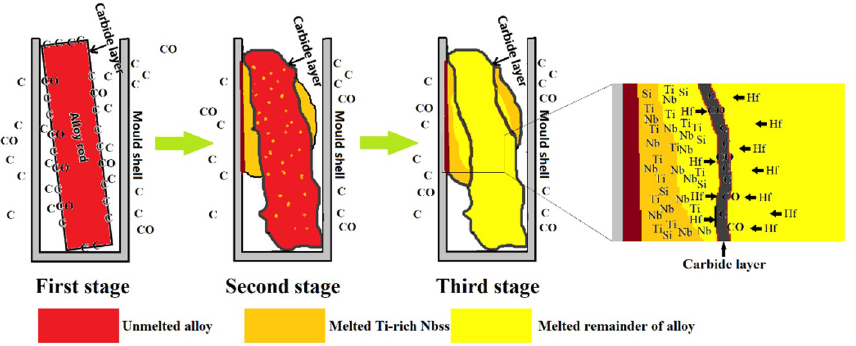
Figure 11. Schematic drawings of the re-melting process of Nb–Si-based ultrahigh-temperature alloy in the furnace with a graphite heating element.